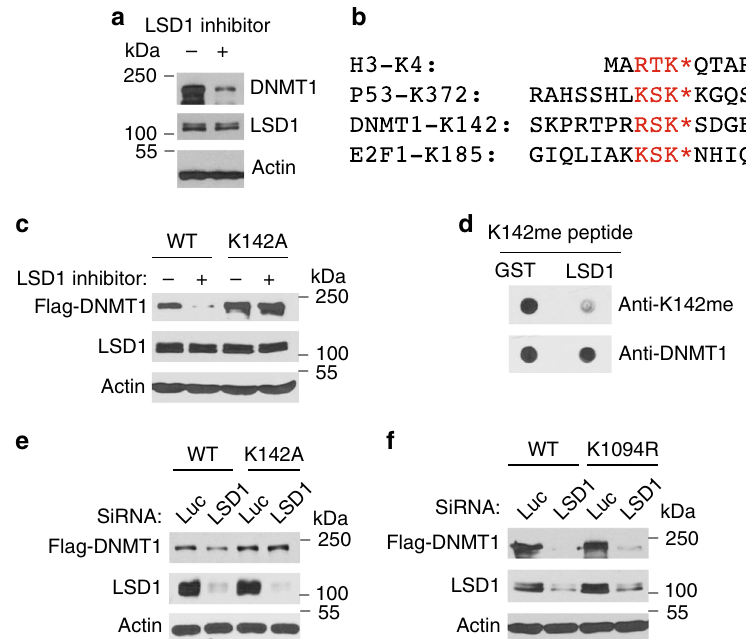
Fig. 1 Regulation of DNMT1 proteolysis by LSD1 demethylase. a Inhibition of LSD1 leads to downregulation of DNMT1. HCT116 cells were treated